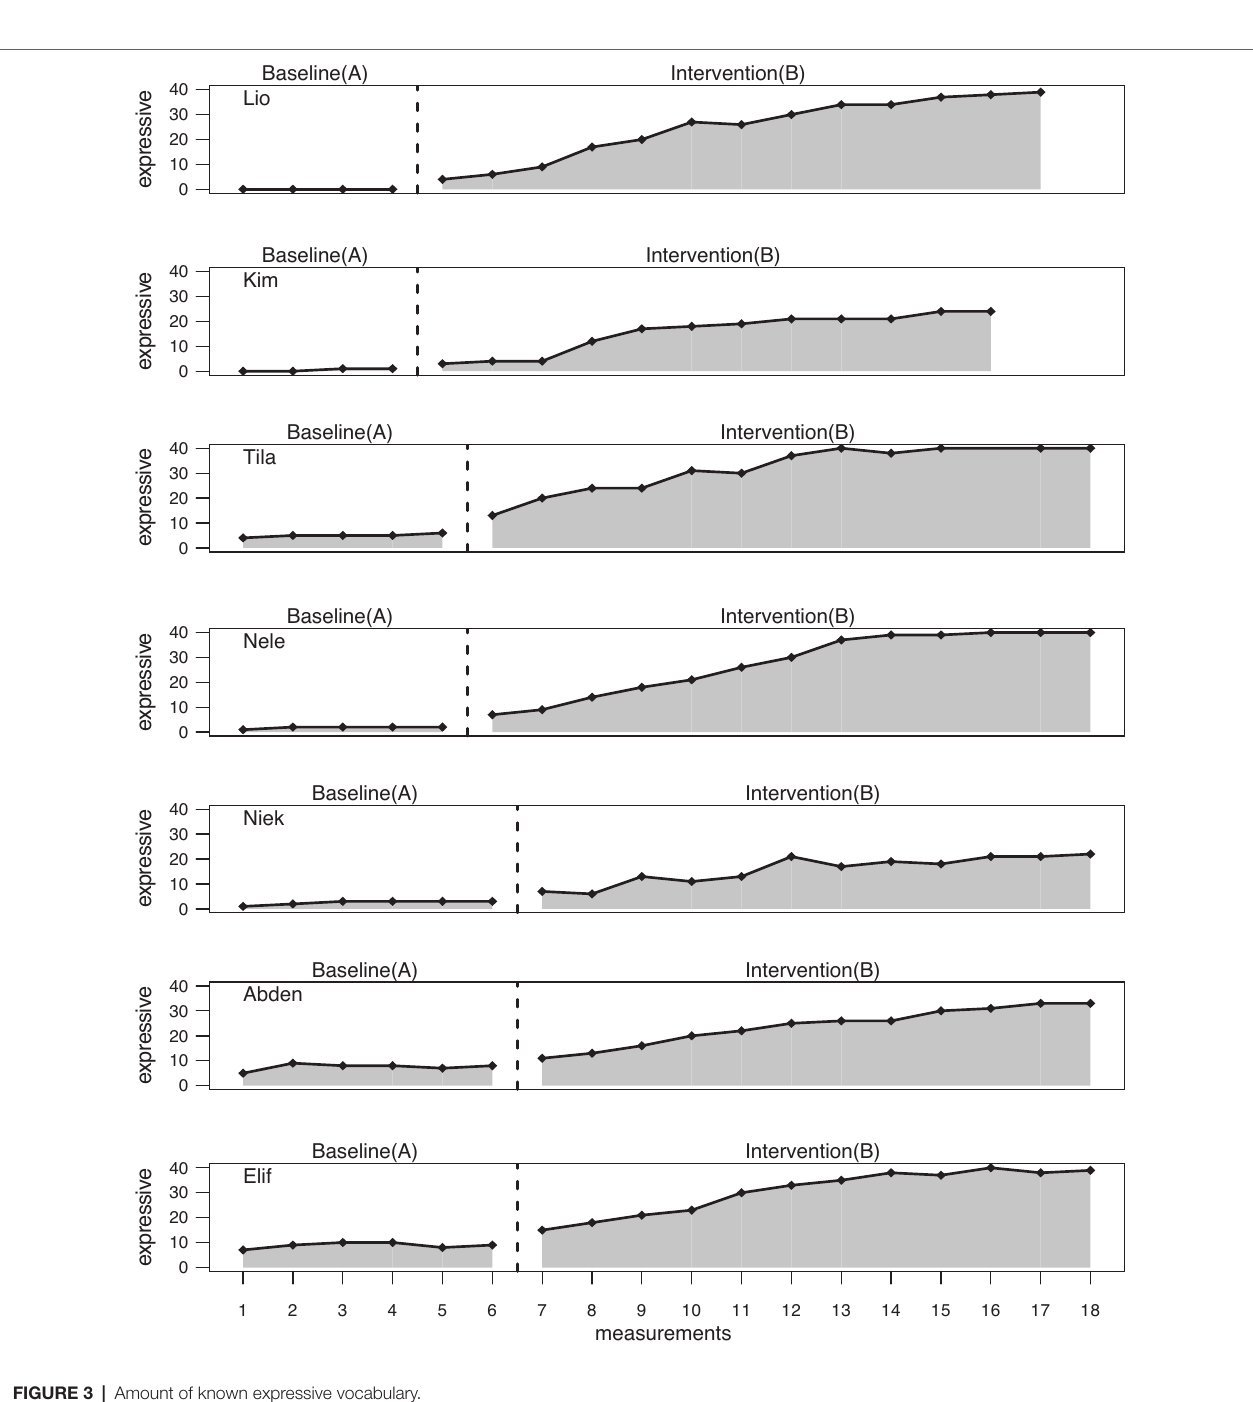
FIGURE 3 | Amount of known expressive